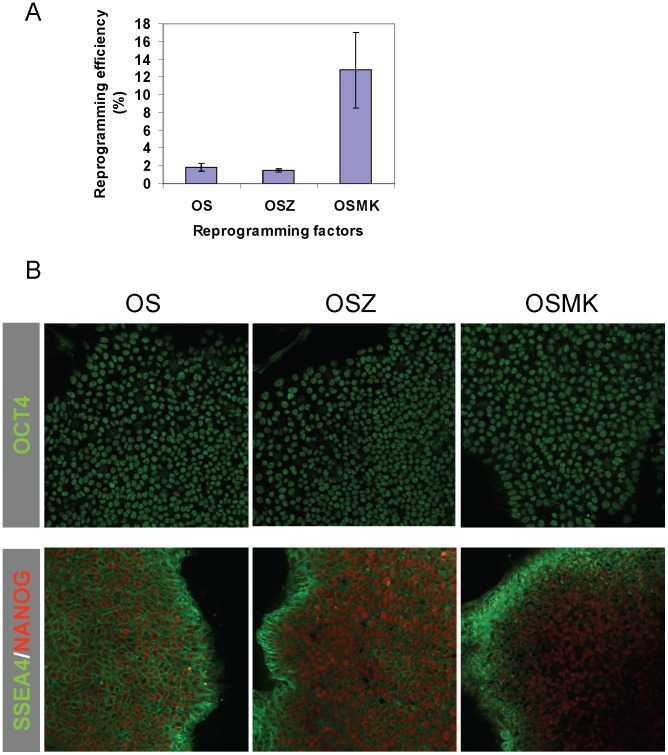
Efficient generation of iPSCs from cord blood CD34+ cells.(A) Efficient reprogramming of cord blood with lentiviral vectors. Three different combinations of reprogramming factors were used: OCT4 and SOX2 (OS), OS+ZSCAN4 (OSZ), and OS+MYC and KLF4 (OSMK). After transduction, 2500–5000 cells were seeded in 6-well plates. iPSC colonies were counted 2 weeks later and reprogramming efficiencies were calculated accordingly. (B) iPSCs express pluripotency makers OCT4, NANOG and SSEA4. Representative pictures for each group (OS iPSC lines, OSZ iPSC lines, and MK iPSC lines (OSMK)) are presented (200×). Confocal imaging did not identify any differences in expression of pluripotency makers among 15 iPSC lines.